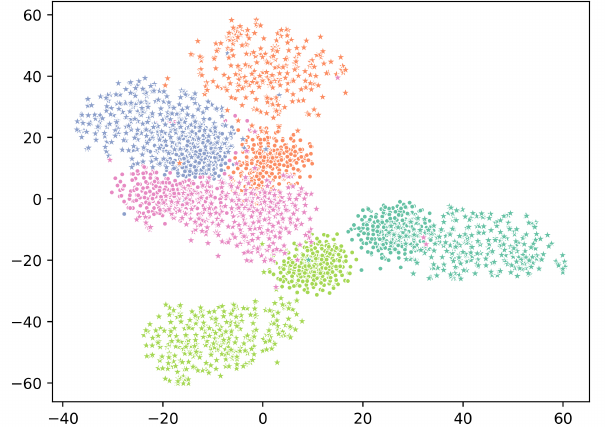
Figure 7. t-SNE visualizations of image features for five unseen classes on the AID30 dataset. The pentagram denotes the real features of the unseen class. The solid circle denotes the synthetic features of the unseen class. The real and synthetic features of the same unseen class have the same